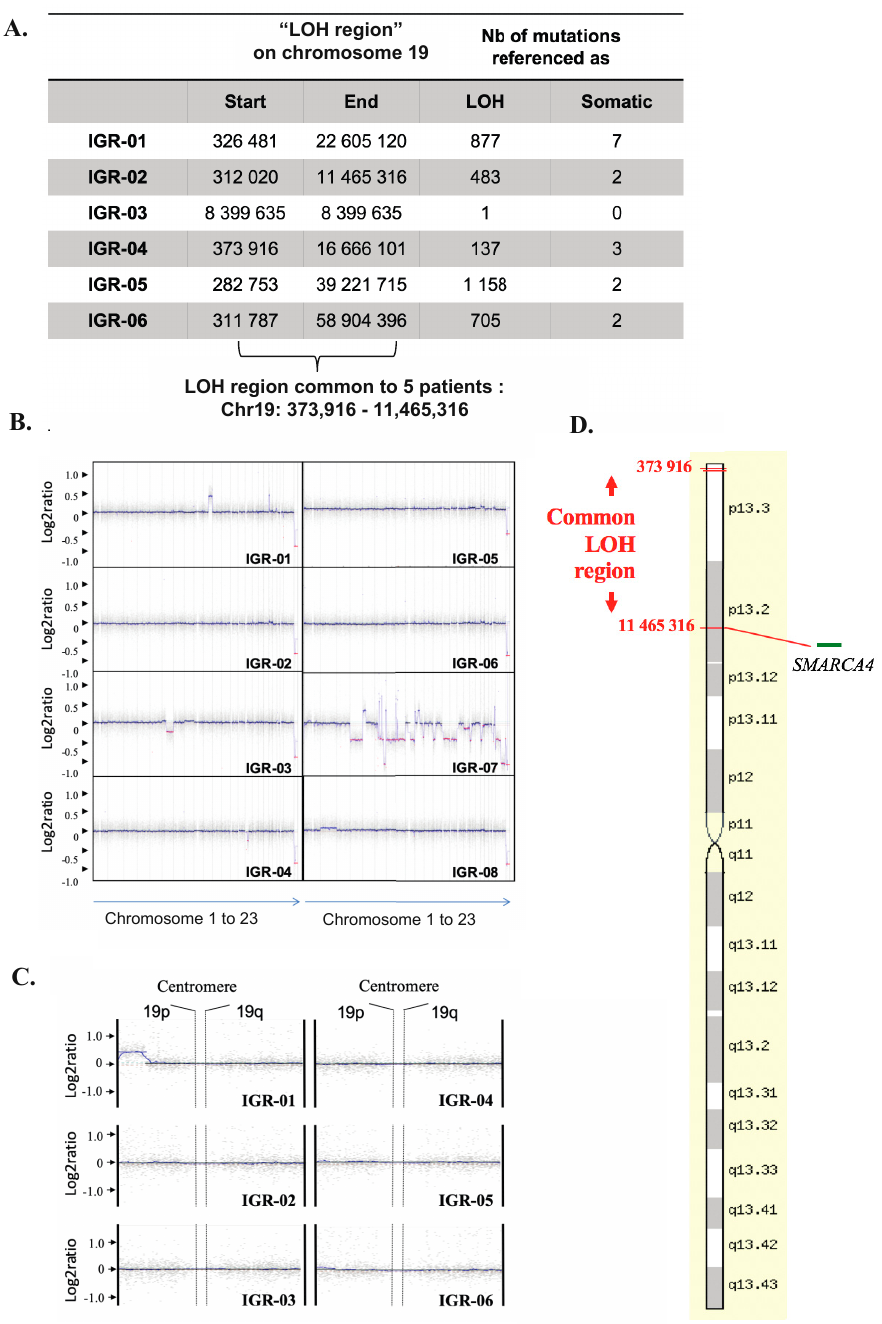
Figure 3. SCCOHT demonstrate remarkable genomic stability and recurrent 19p CN-LOH. ( A ) LOH regions obtained by WES in each tumor identifies a common “LOH region” on chromosome 19 for all SCCOHTs except IGR03: Chr19:373916-11465316. ( B ) CGH array profiles for each patient. ( C ) Zoom on 19p in all tumors fails to show a heterozygous copy number loss, thus suggestive of copy neutral LOH. ( D ) Artificial representation of the “common LOH region” on chromosome 19 in tumors (source: http://www.genecards.org ).